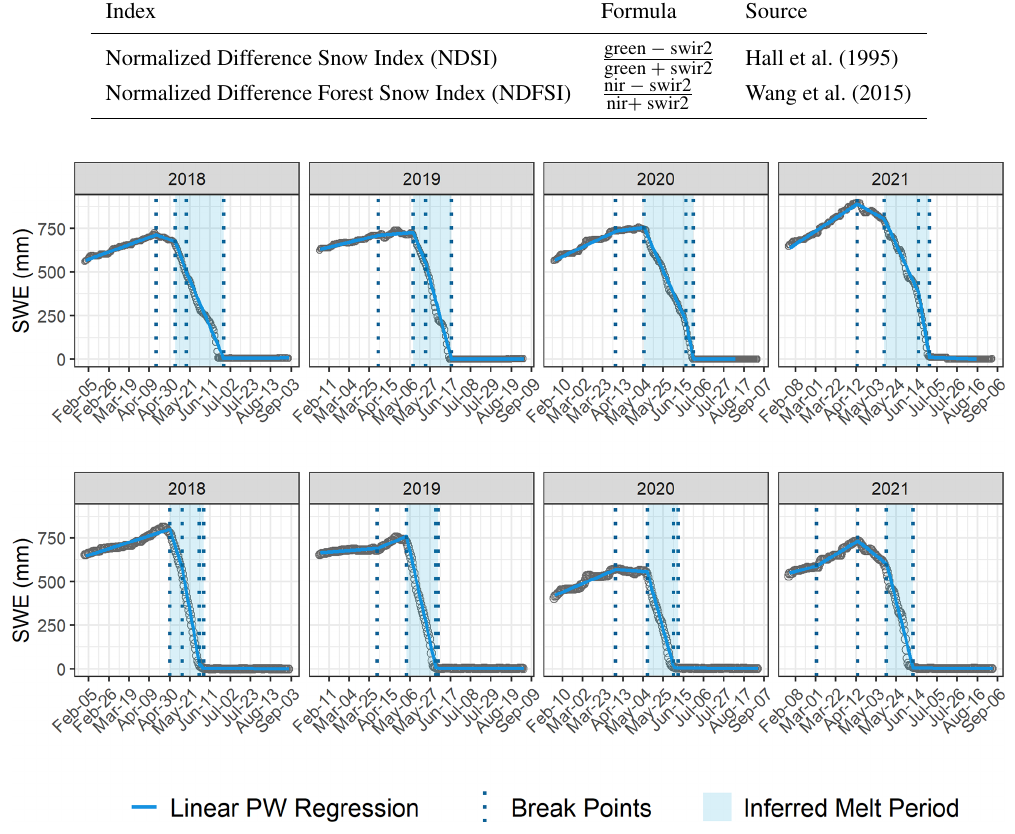
Figure 2. Snow water equivalence records from Downton Lake Upper (top) and Green Mountain (bottom). Linear piecewise regressions of SWE trends are displayed with observational data. Breakpoints in the regression are marked with vertical dotted lines, and the inferred melt period from the regression is shaded in light